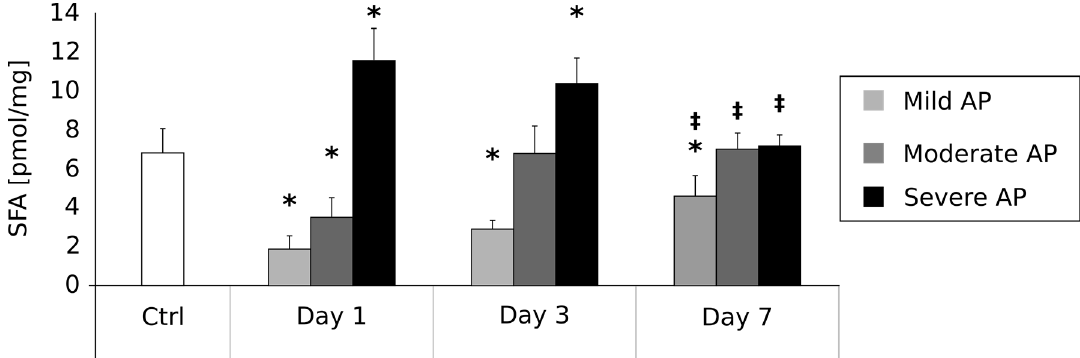
Figure 1. Alterations in sphinganine concentrations (pmol/mg) in the course of acute pancreatitis. * = difference vs. Control, p < 0.05; ‡ = difference vs. Day 1, p < 0.05.